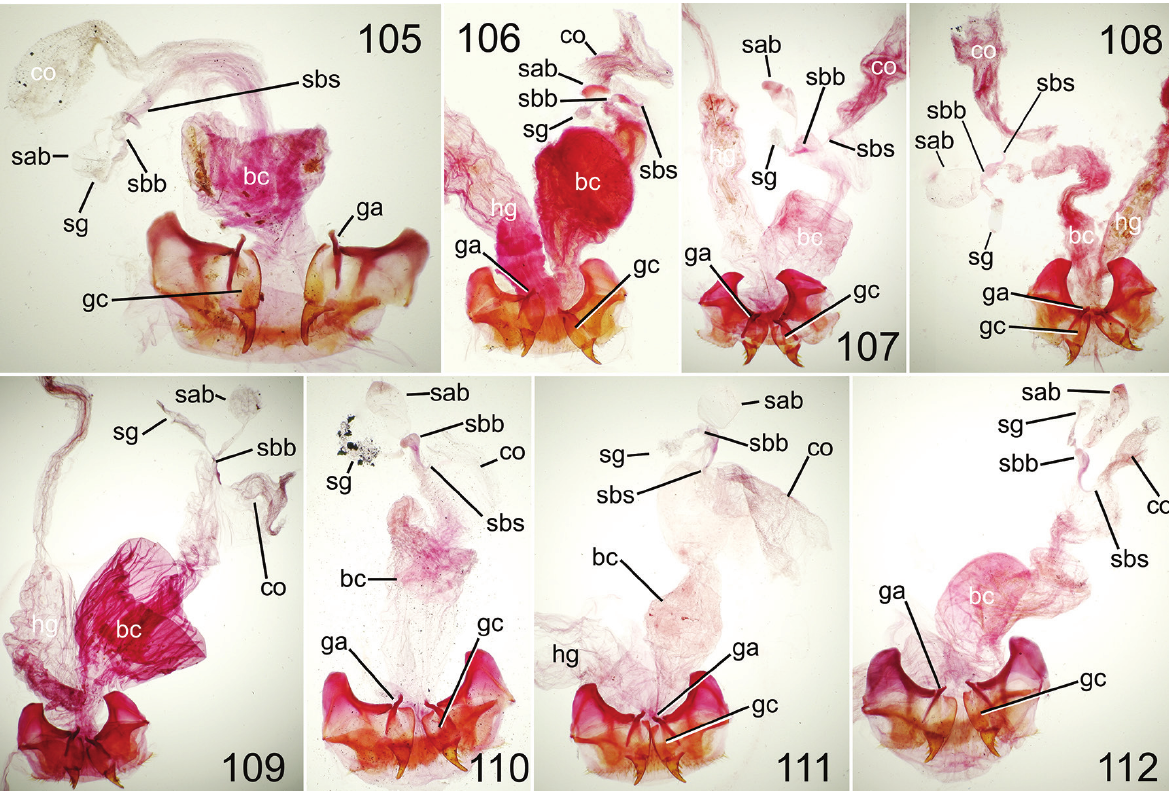
Figures 105–112. Female reproductive tract, ventral view, for Cyphocoleus spp.; 105 , C. mirabilis , Mt. Koghi; 106 , C. fasciatus